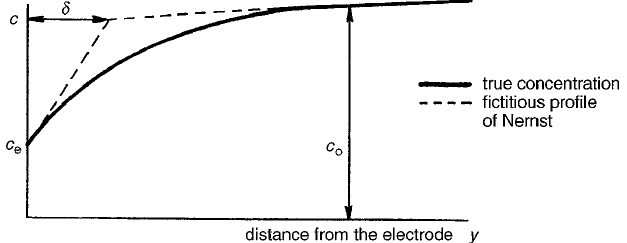
FIG. 2. Representation of the Nernst diffusion layer profile model